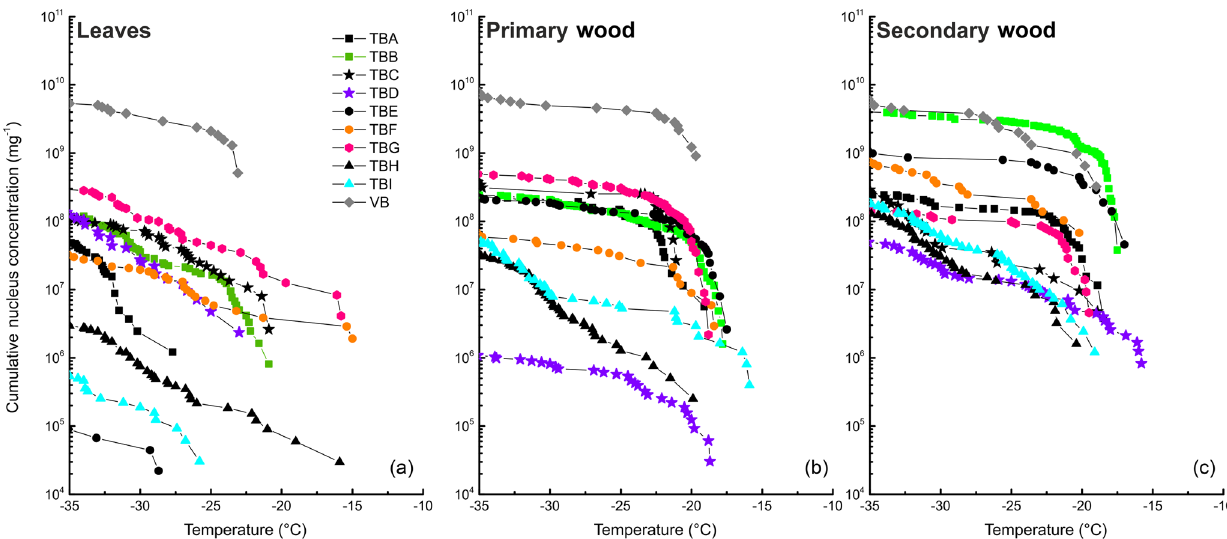
Figure 4. Cumulative nucleus concentration as a function of temperature for leaf extracts (a) , primary wood extracts (b) , and secondary wood extracts (c) . The diagram is cut off at − 35 ◦ C, since we cannot contribute freezing events below this temperature to heterogeneous nucleation. The symbols used for the different data points are grouped. Birches growing in close proximity under similar conditions are marked with the same symbol (different fillings).